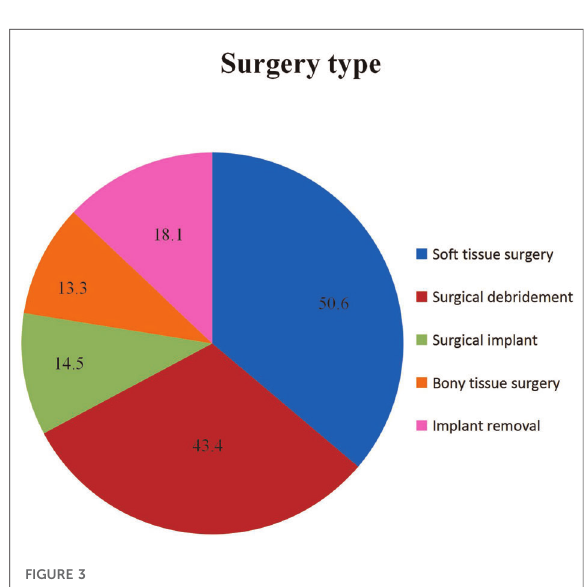
FIGURE 2 Percentage of patient (%) according to ethnicity.